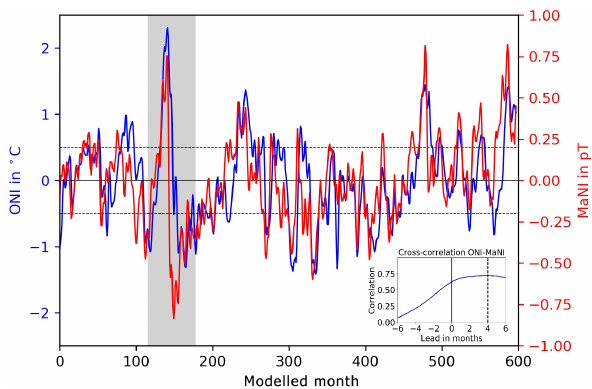
Figure 1. ENSO indices. ONI derived from sea surface tempera- tures (blue curve) and MaNI derived from the radial tidally induced magnetic field B r (red curve). The dashed lines mark the threshold of ± 0.5 ◦ C, the threshold for El Niño and La Niña events. The grey shaded area marks the strongest cycle of ENSO events (used for further analysis). The embedded plot shows the cross-correlation between ONI and MaNI. For positive leads, MaNI leads